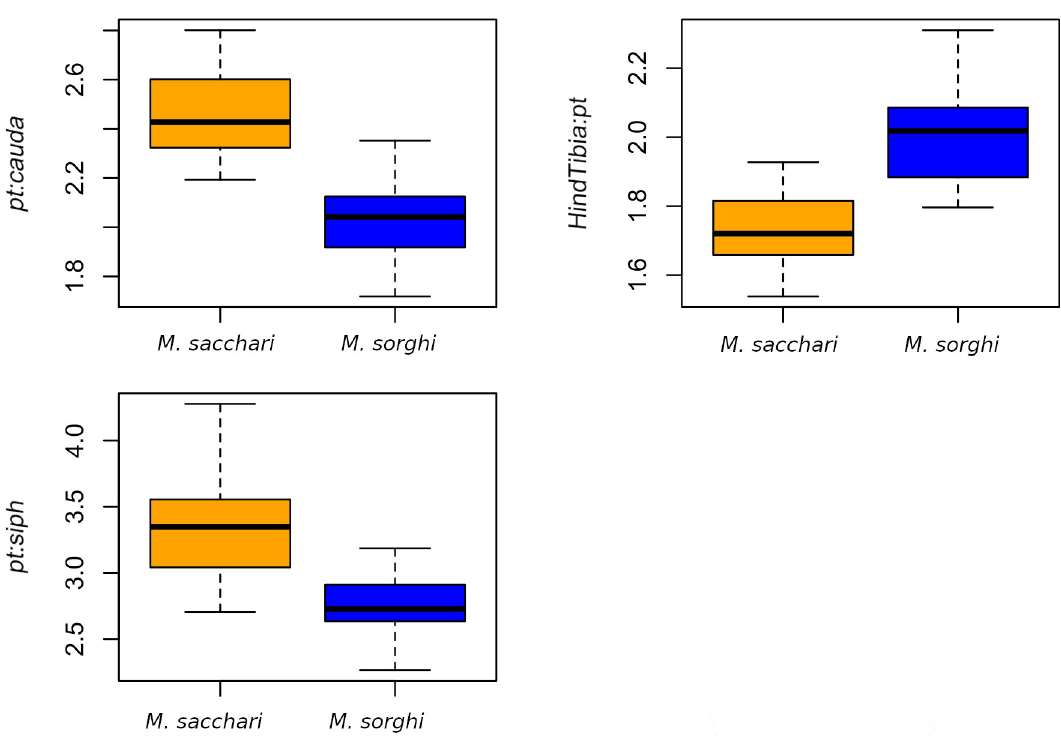
Fig 2. Comparison between M . sacchari and M . sorghi using the three traits showing the highest loadings in the DAPC among 51 slide-fixed specimens. The specimens are assigned to M . sorghi or M . sacchari according to their SSR or EF1- α genotype.